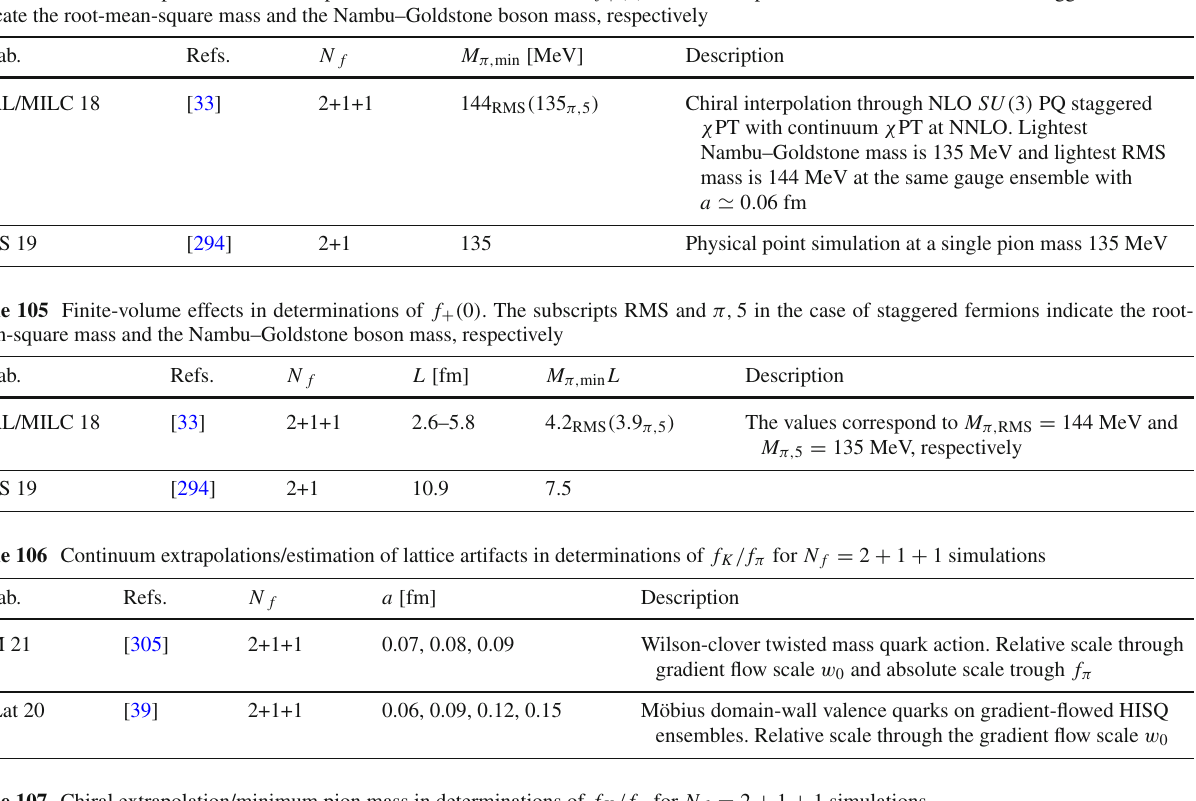
Table 107 Chiral extrapolation/minimum pion mass in determinations of f K / f π for N f = 2 + 1 + 1 simulations Collab.